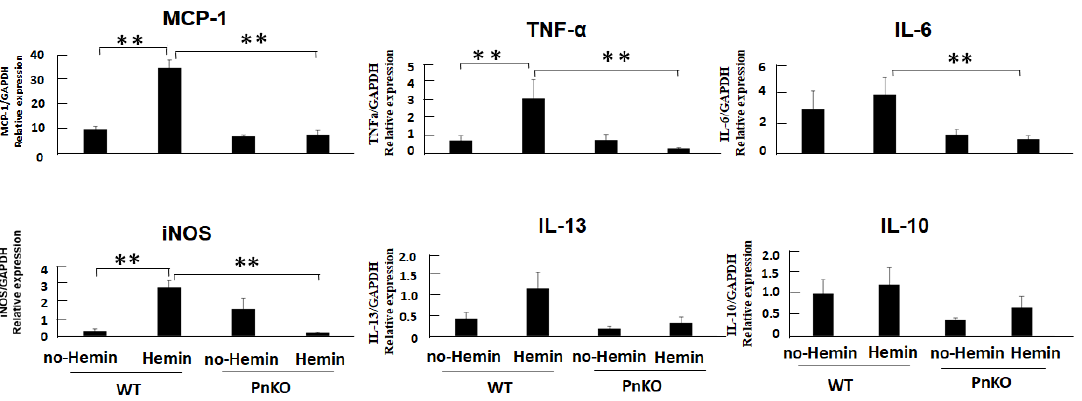
Figure 6. The expression of periostin and inflammation markers in the NIH3T3 fibroblasts after Hemin stimulation. All markers of inflammation declined in the periostin-knockdown NIH3T3 cells with hemin compared with the wildtype NIH3T3 fibroblasts with hemin. ** p < 0.05 vs. day 0 (WT) and day 3 (PnKO). n = 4.